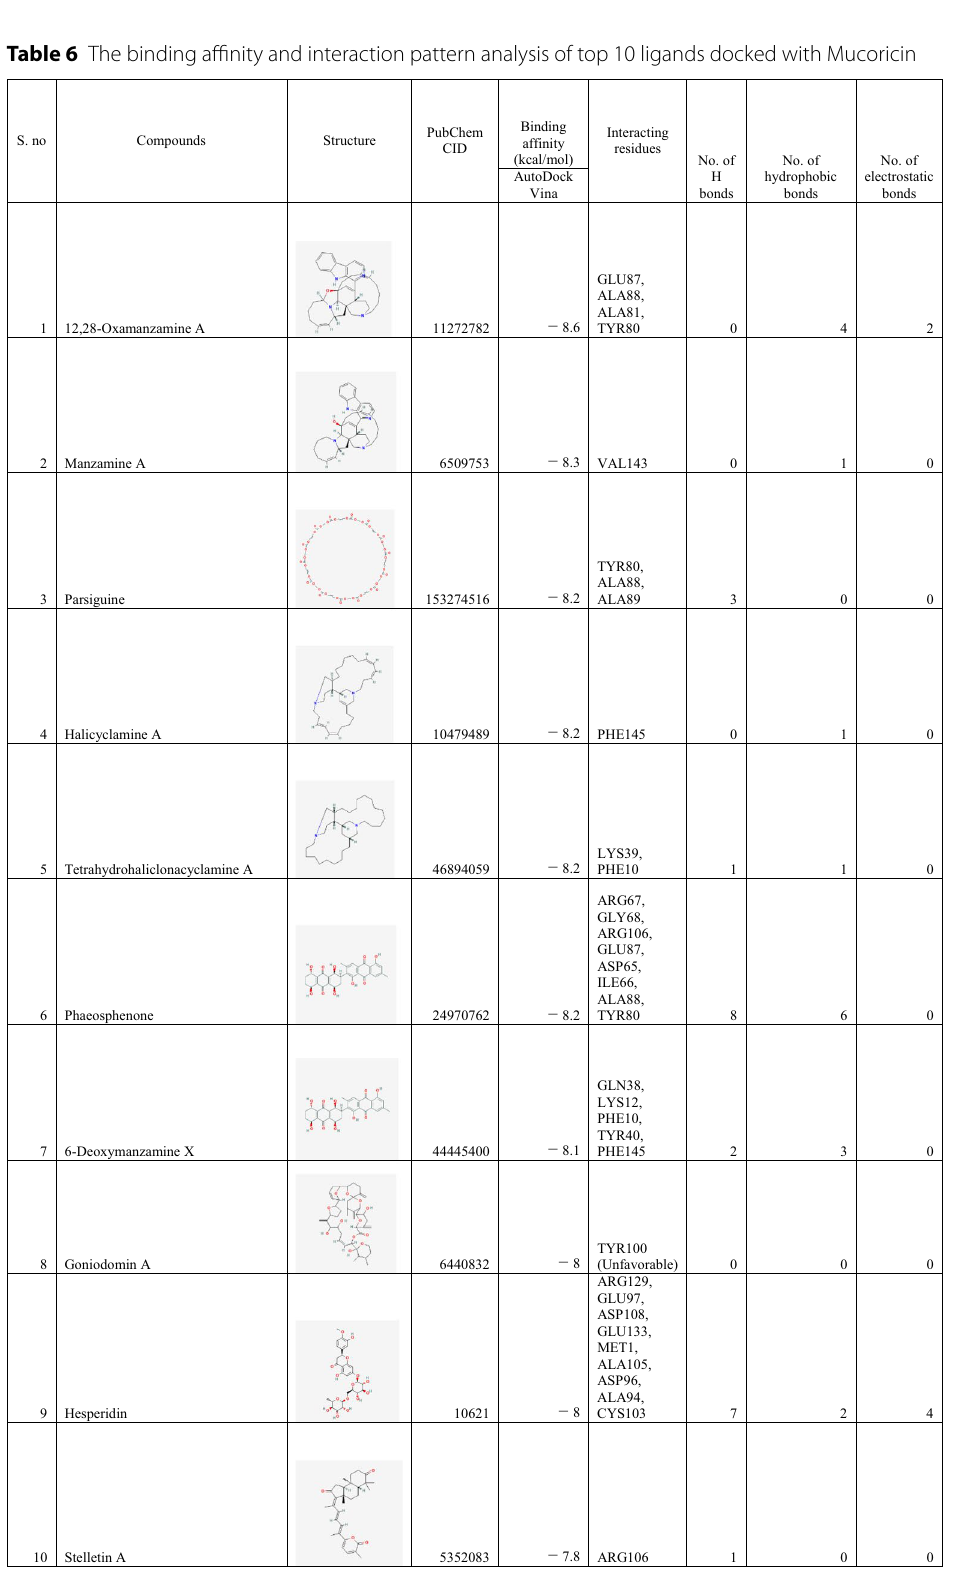
Table 6 The binding affinity and interaction pattern analysis of top 10 ligands docked with Mucoricin